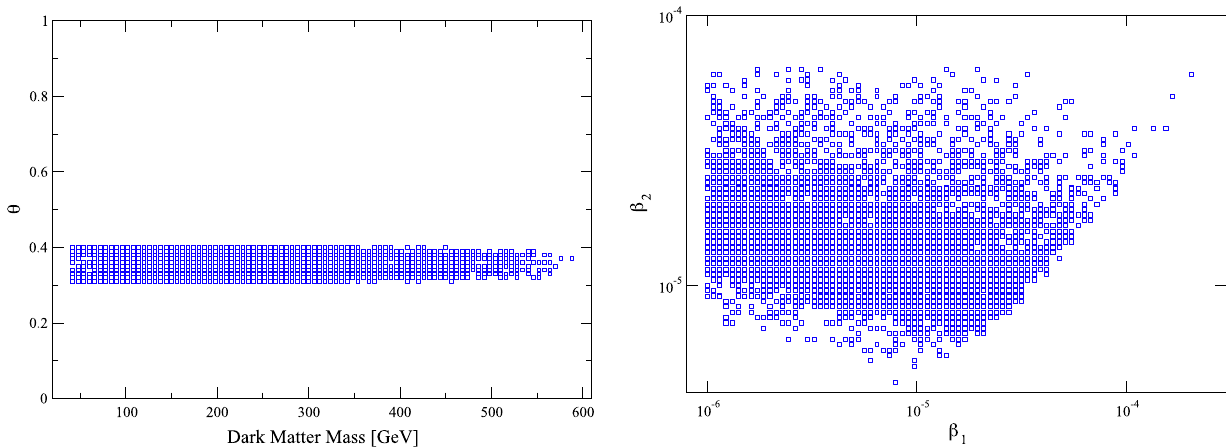
Fig. 4 Left: the viable models projected onto the plane ( m φ , θ ). Notice that the experimental constraints essentially select a single value of θ . Right: the viable models projected onto the plane ( β 1 , β 2 ). Neutrino masses require β 1 , 2 to be small